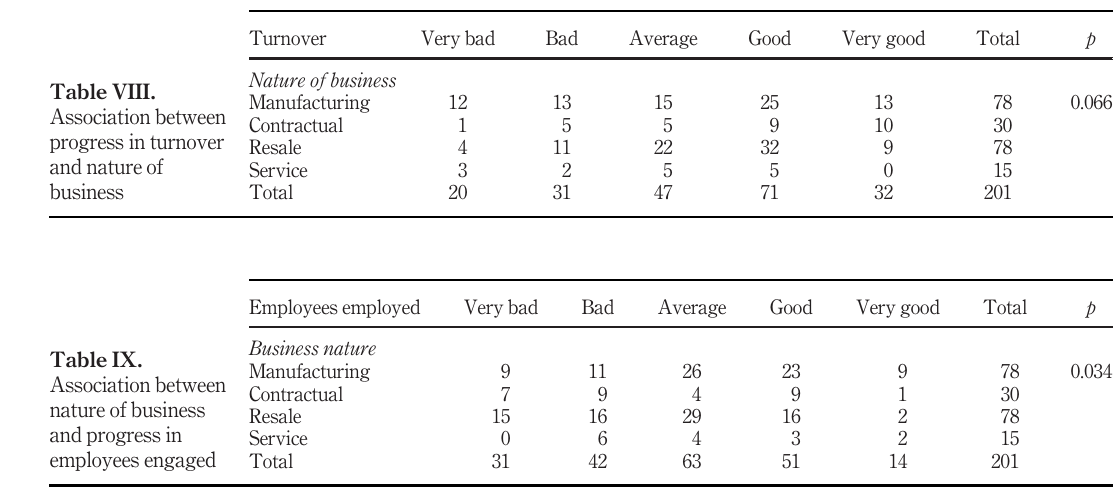
nature of business and progress in employees